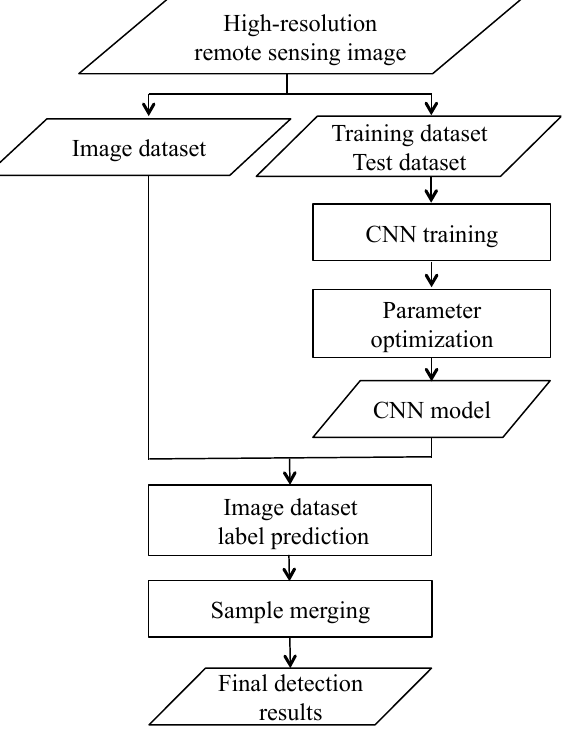
Figure 2. The flowchart of our proposed method.